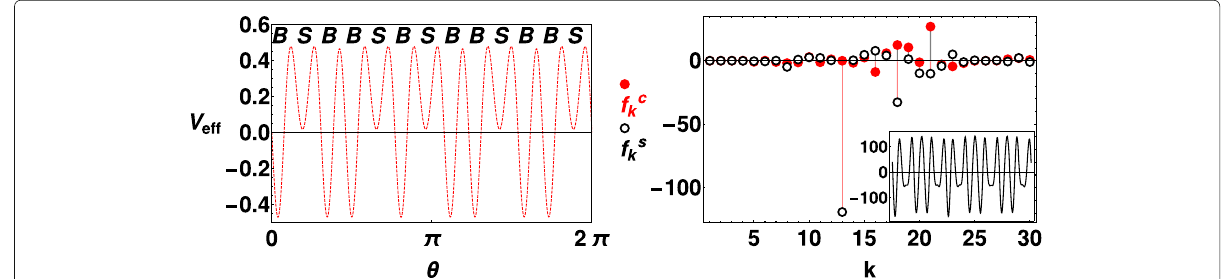
Fig. 5 Left panel: quasi-crystal structure in time. The motion of the mirror is chosen so that the effective potential V eff ((cid:6)) in Eq. (2) is a finite fragment of the Fibonacci sequence of small ( S ) and big ( B ) potential wells. Right panel: Fourier components of the mirror oscillations, (cid:5) c cos ( k ω t ) + f s sin ( k ω t ) ] — the inset shows f ( t )/ω 2 over one period T = 2 π/ω . Reprinted from f ( t )/ω 2 = k [ f k k